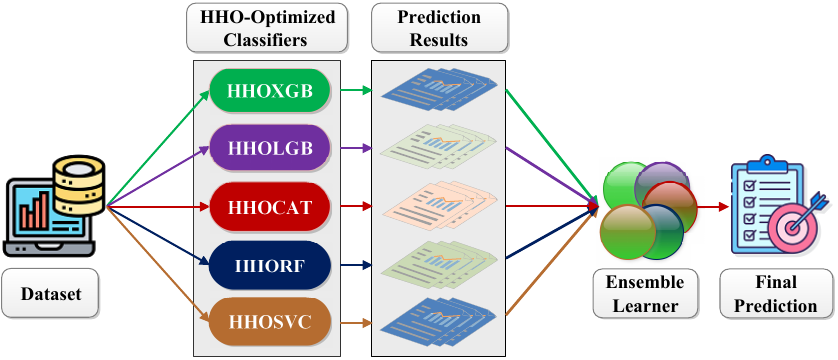
Figure 2. Block diagram of ensemble